Question: What caption would you write for this figure?
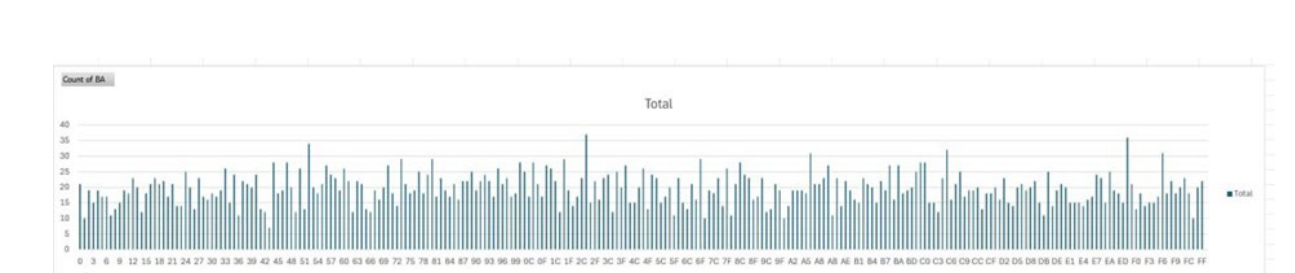
Answer: Statistical distribution before RNG value is converted to the chosen dice range.